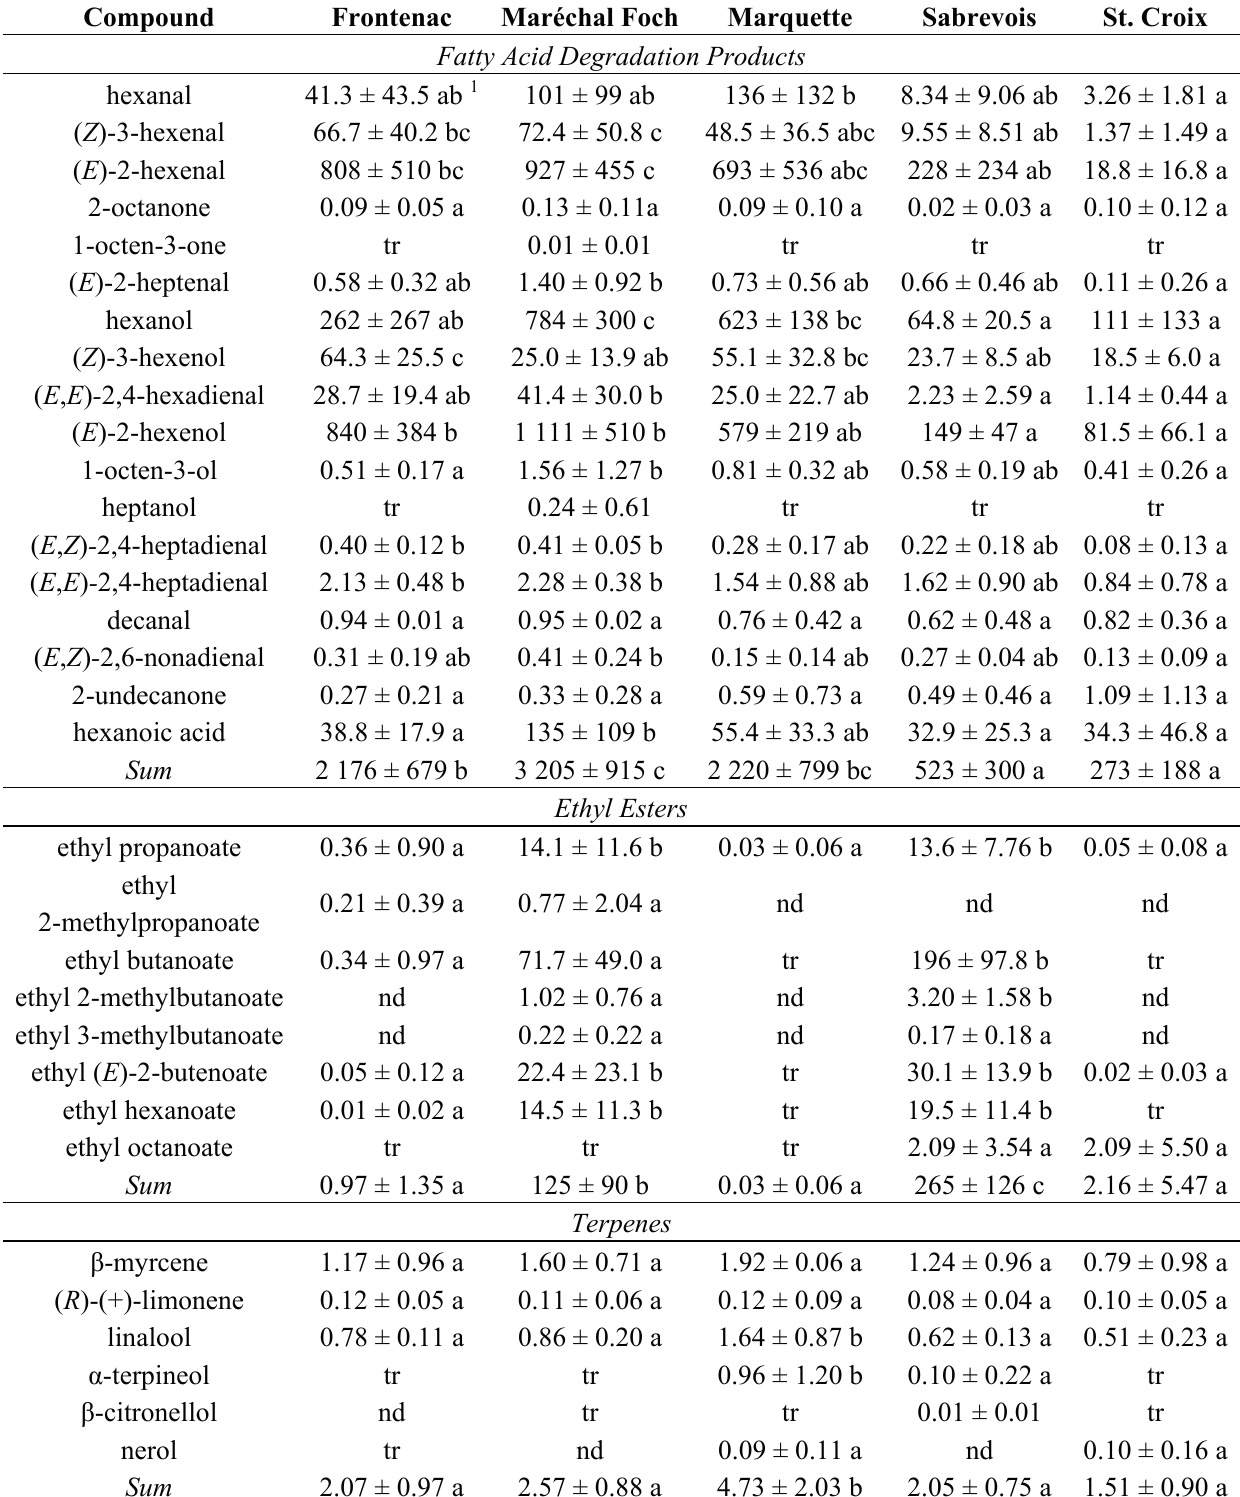
Table 2. Free volatile compound ( μ g/L) from the juice of the interspecific hybrid grape varieties Frontenac, Maréchal Foch, Marquette, Sabrevois, and St. Croix harvested in the province of Québec (Canada), during the season